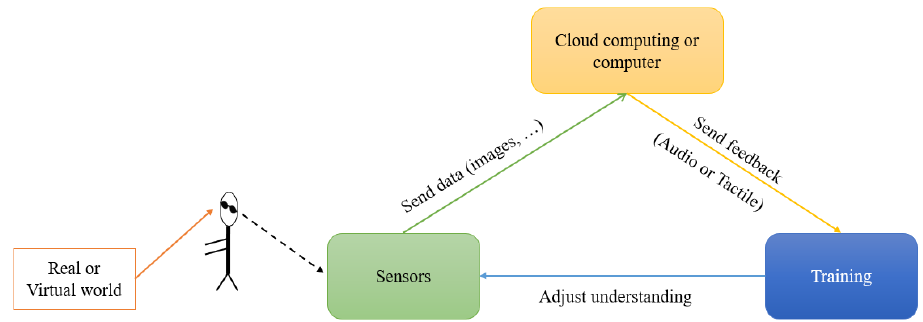
Figure 1. Sensory substitution